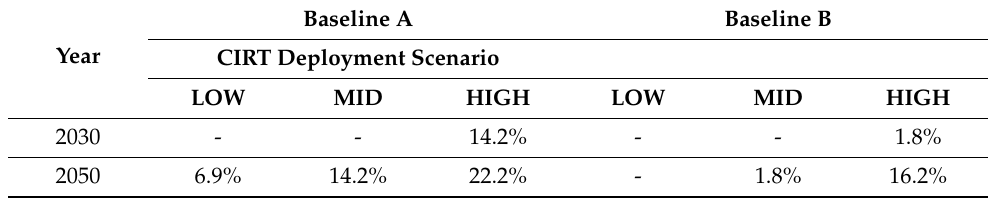
Table 5. Projected share of LCAF in total EU-27 jet fuel refinery output for the analyzed